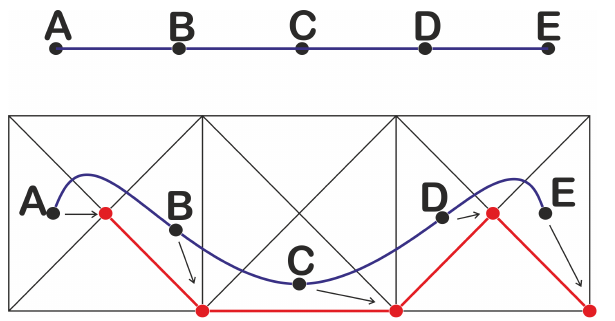
Figure 3. On the top, we can see a 1-simplex with two iterated applications of the barycentric subdivision. On the bottom, a continuous function was applied to the straight line and a simpli- cial approximation (in red) is provided. The star condition is satisfied and no more barycentric subdivisions are